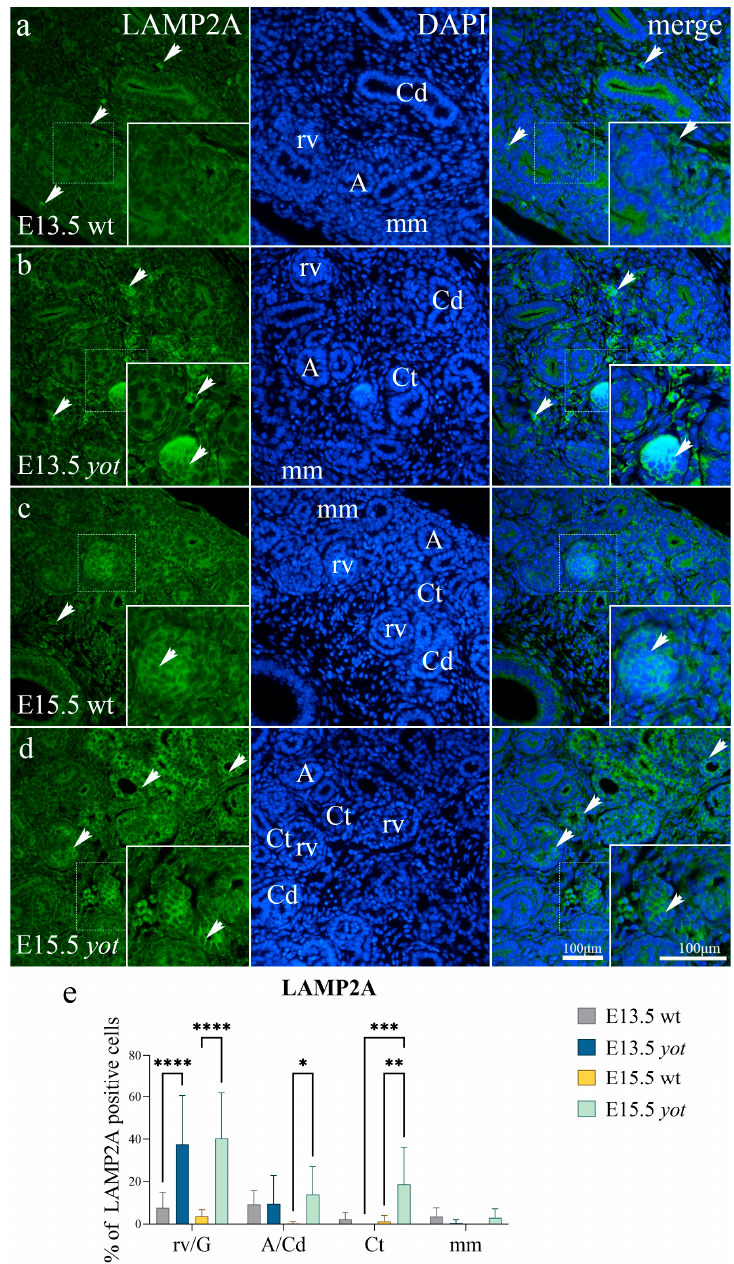
Figure 7. Immunofluorescence staining of developing wild-type (wt) ( a , c ) and yotari ( b , d ) mouse kidneys with LAMP2A marker and DAPI nuclear staining. Three mice were used for each genotype ( yotari and wt) at every observed time point. Arrows show the expression pattern of LAMP2A in the metanephric mesenchyme (mm), renal vesicles (rv), glomeruli (G), convoluted tubules (Ct), ampullae (A), and collecting ducts (Cd) indicated on the 4 ′ ,6-diamidino-2-phenylindole (DAPI) image. The most prominent protein expression area is shown in the inserts, corresponding to the dashed boxes. Images were taken at a magnification of ×40. The scale bar is 100 µm, which refers to all images. Graph ( e ) shows the distribution of the percentage of LAMP2A-positive cells in the metanephric mesenchyme (mm), renal vesicles (rv) or glomeruli (G), convoluted tubules (Ct), and ampulla (A) or collecting ducts (Cd) of wild-type and yotari kidneys at embryonic days E13.5 and E15.5. Data are presented as the mean ± SD (vertical line) and analyzed by a two-way ANOVA test followed by Tukey’s multiple comparison test. Significant differences are indicated by * p < 0.05, ** p < 0.001, *** p < 0.0001, **** p < 0.00001. At each time point, ten substructures were assessed.